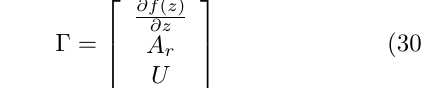
Table 4: Simulation results